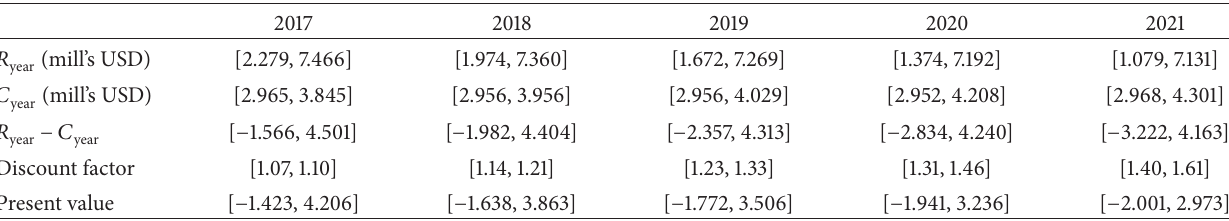
Table 7: Discounted cash flow over production period